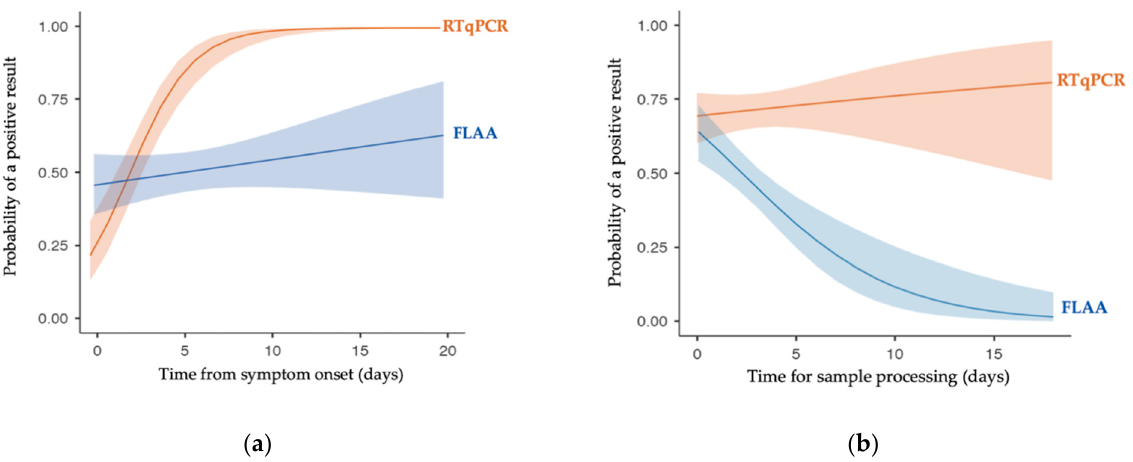
Figure 6. Estimated marginal means plots for ( a ) time from symptoms onset and ( b ) time for sample processing.